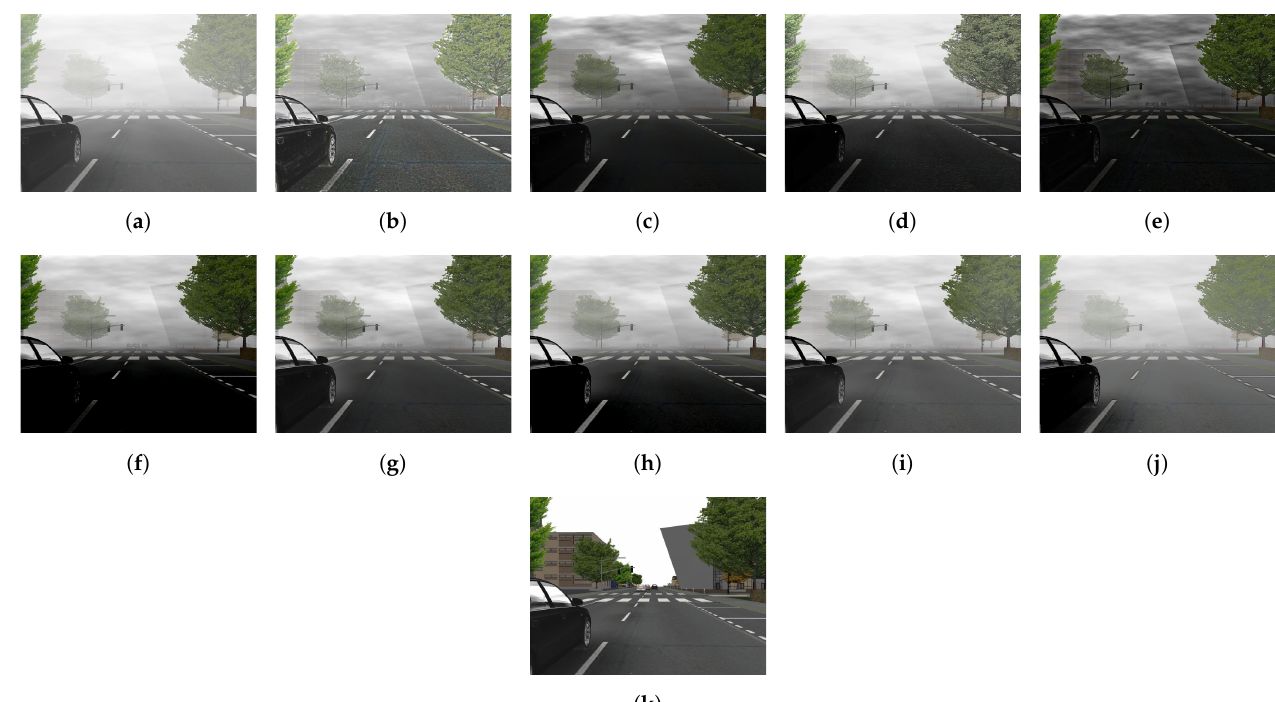
Figure 22. A qualitative comparison of different dehazing methods on a synthetic hazy image of a road scene. ( a ) Hazy image, results by ( b ) Tarel and Hautiere [35], ( c ) He et al. [21], ( d ) Kim et al. [36], ( e ) Bui and Kim [50], ( f ) Zhu et al. [52], ( g ) Ngo et al. [74], ( h ) Cai et al. [85], ( i ) Ren et al. [89], ( j ) and the proposed framework, and ( k ) ground